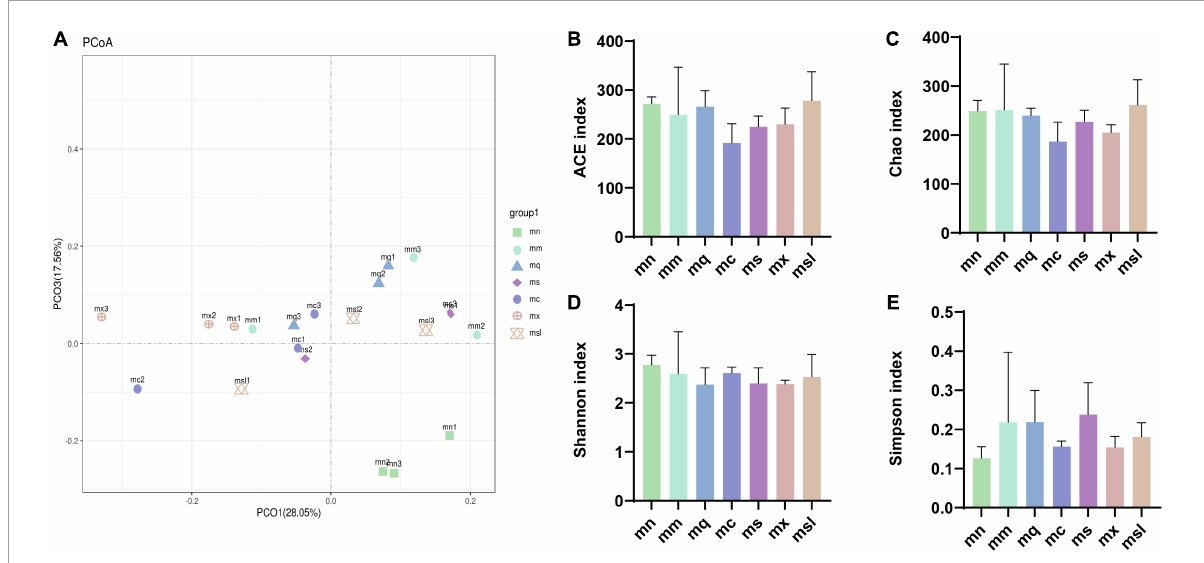
FIGURE3 The altered bacterial diversity and richness of the intestinal mucosal microbiota in AAD mice treated with QWBZP with different sweeteners. (A) Principal component analysis. (B–E) ACE index, Chao1 index, Shannon index, Simpson index (Data were mean ± SD, One-way ANOVA with LSD or rank sum test with Kruskal-Wallis, * p < 0.05). mn, Control group; mm, Model group; mq, QWBZP group; ms, QWBZP + Sucrose group; mc, QWBZP + Saccharinn group; mx, QWBZP + Xylitol group; msl, QWBZP + Sorbitol